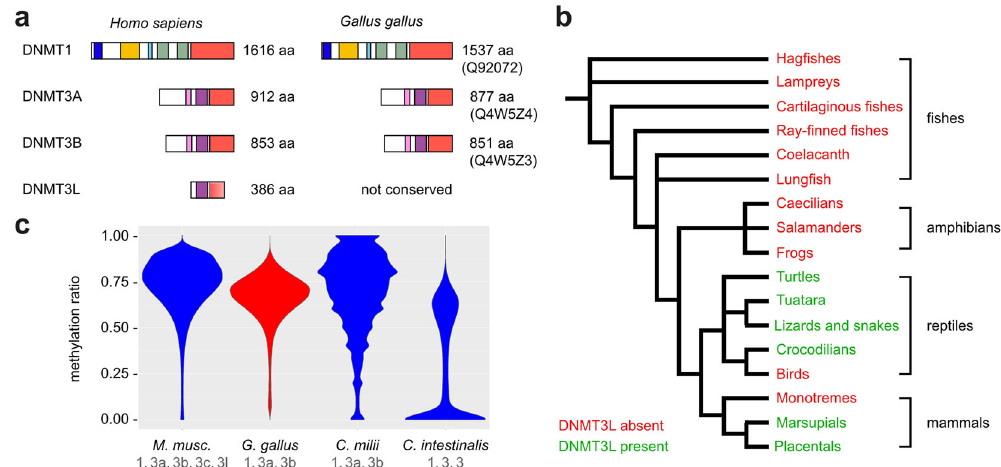
Fig. 1 A conserved DNA methylation system in chicken. a Conservation of canonical DNMT enzymes in chicken. Conserved domains of animal DNMTs are shown in different colors. All DNMTs: catalytic domain (red). DNMT1: DMAP1 binding domain (dark blue), replication foci targeting domain (orange), CXXC domain (turquoise), BAH domain (green). DNMT3: PWWP domain (pink), ADD domain (purple). DNMT3L is a catalytically inactive DNMT3